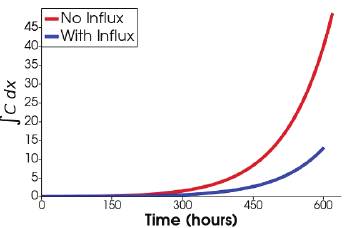
Figure 10. Evolution of the integral of cancer over the domain with and without immune cell